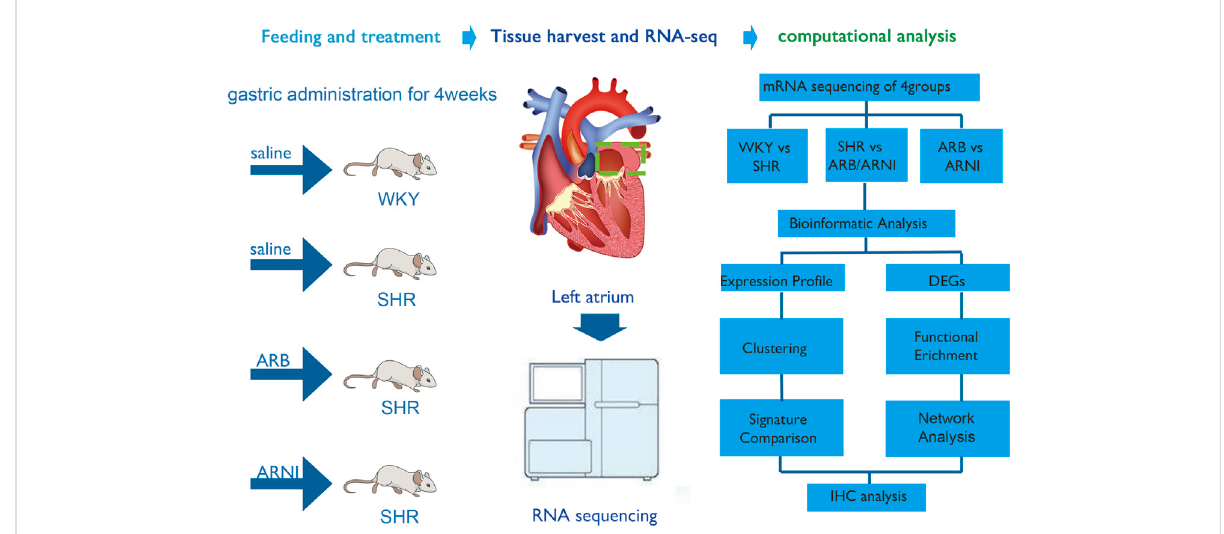
FIGURE 1 An overall fl ow chart of the experimental design. WKY, Wistar-Kyoto; SHR, spontaneously hypertensive rat; ARB, angiotensin receptor blocker; ARNI, angiotensin receptor/neprilysin inhibitor; DEGs, differentially expressed genes; IHC, immunohistochemistry.